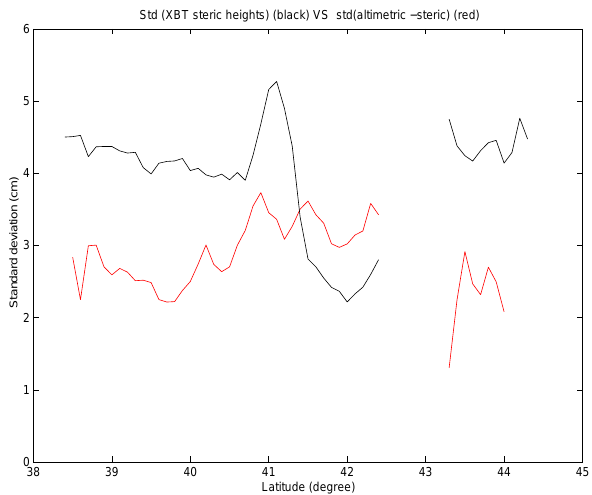
Fig. 7. Standard deviation of steric height (0/300dbars), as a func- tion of latitude, based on the 22 cruises (black line) and RMS be- tween steric height and altimetric height (red